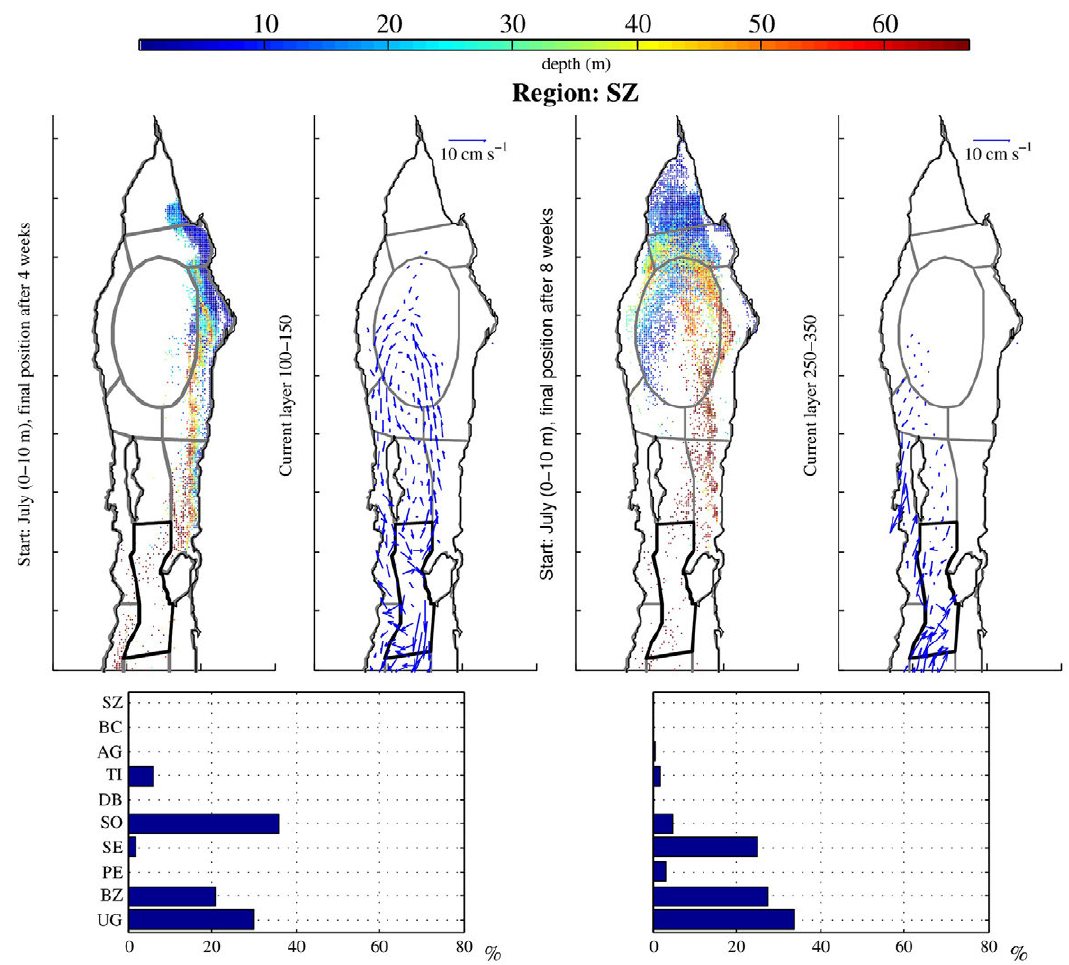
Fig. 9. – Map of final position of particles released in the Sills Zone’s first layer, in the fourth and eighth week after the release of particles. The release area is shown in black and the other areas in grey polygon. The colour bar represents the depth at which each particle is located. The histogram shows the percentage of particles retained or transferred to other regions. Current maps correspond to the layer in which the percentage of particles retained is concentrated, in the fourth and eighth week after particle